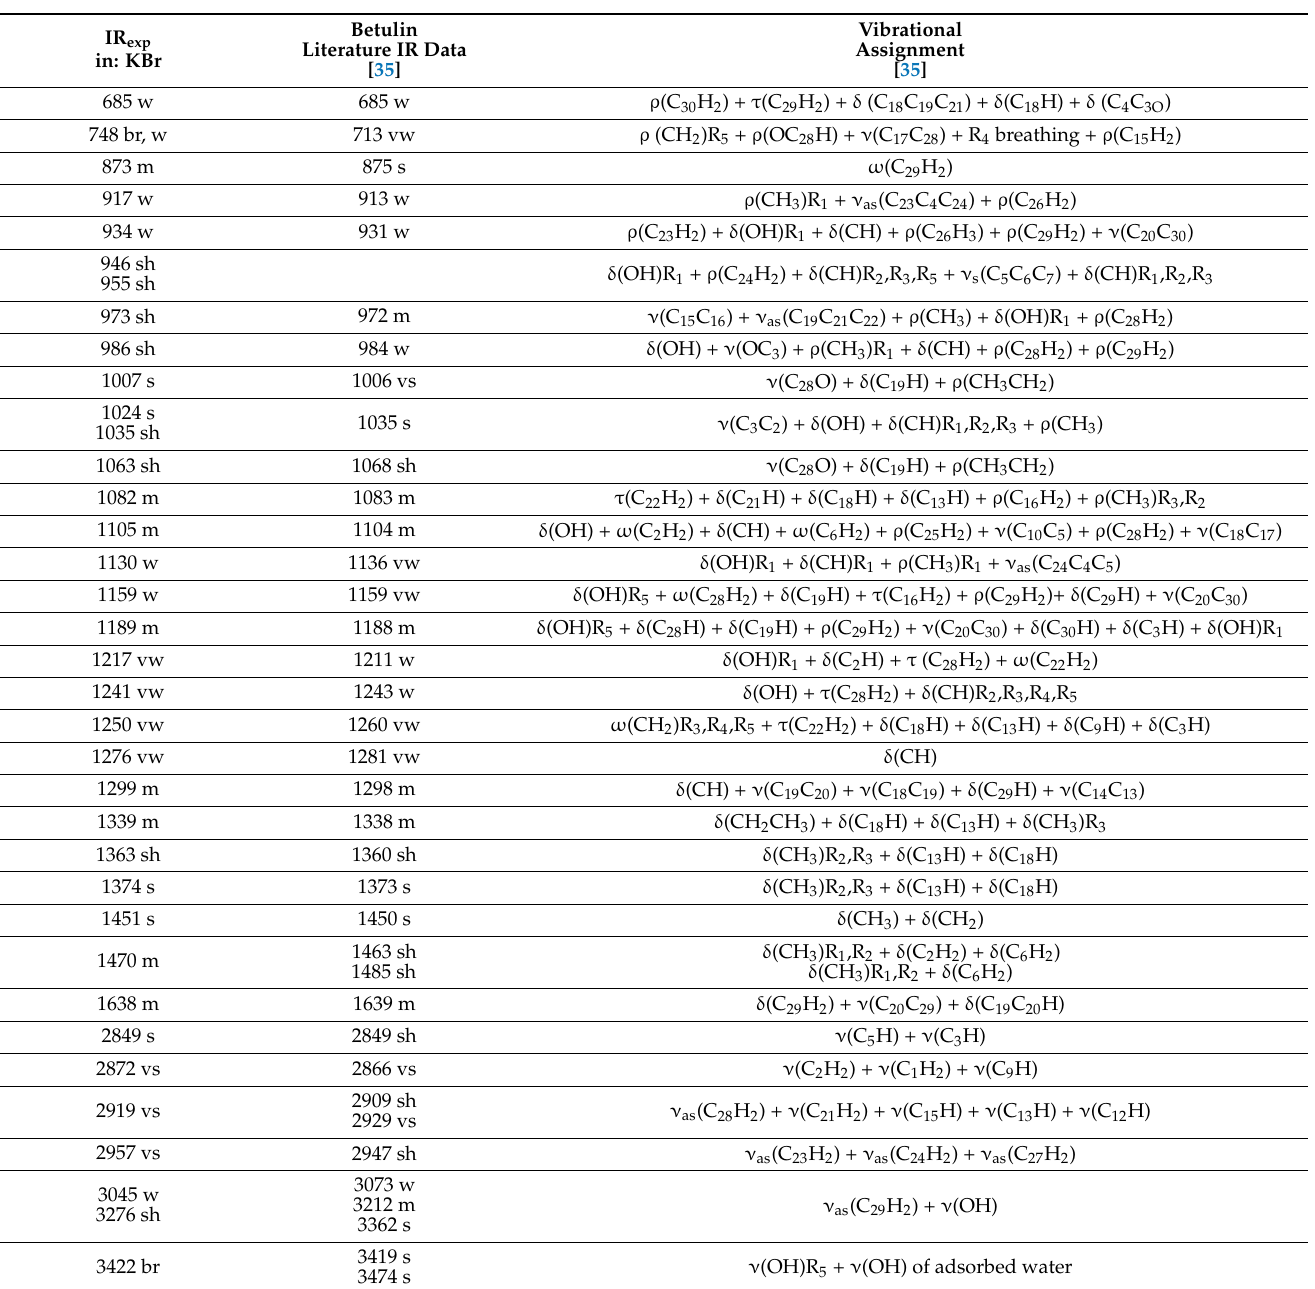
Table 1. Comparison of band positions of the solid product obtained during isolation of betulin from Piptoporus betulinus with an experimental IR spectrum of betulin (vw—very weak, w-weak, sh— shoulder, m—medium, s—strong, vs—very strong, br—broad, ν —stretching, ρ —rocking, δ —bending, τ —twisting; ω —wagging, as—asymmetric,